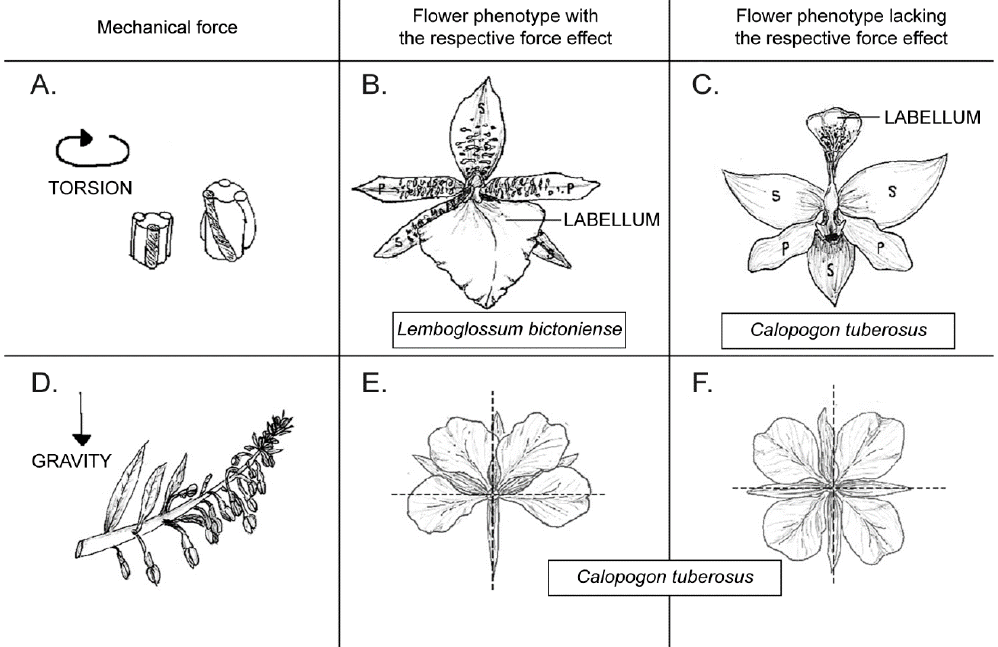
Figure 1. Conceptual proposition of role of mechanical forces on flower phenotype. Pictures in middle ( B , E ) show wild phenotype of a given flower when expected force shown to its left ( A , D , respectively) has acted during its ontogeny. Alternatively, images at right ( C , F ) show the analogous phenotype when that force is not present during ontogeny, highlighting the generative role of respective mechanical force in creating expected flower phenotype: ( A ) depiction of torsion force taking place in a peduncle of a resupinating orchid. Here, torsion is explained as a derived growing force after peduncle extension (represented by a tube) took place (smaller at left before growth; larger at right after growth). Existing lateral ribs of peduncle, represented by three thinner stripes, enlarge more than central tube, and thus forcedly adopt a spiral display to spatially accommodate extra tissue generated within ribs. Torsion of whole structure shown on right is a consequence of this differential growth. One of the ribs is shaded for illustrative purposes. ( B ) Typical resupinated flower of an orchid: in this example, Lemboglossum bictoniense, with its labellum in ventral (abaxial,